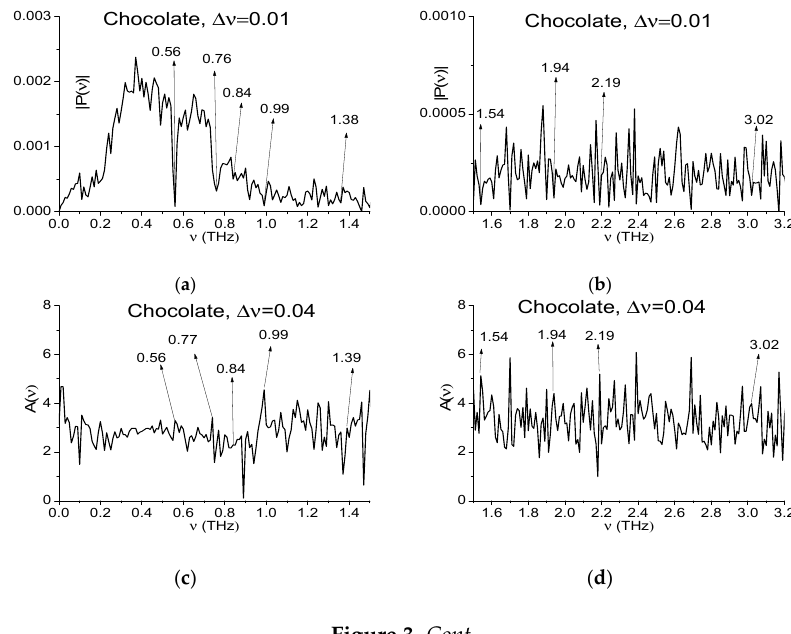
Figure 2. THz signals Chocolate ( a ) and Cookies ( b ) in the time interval t = [0, 110] ps.